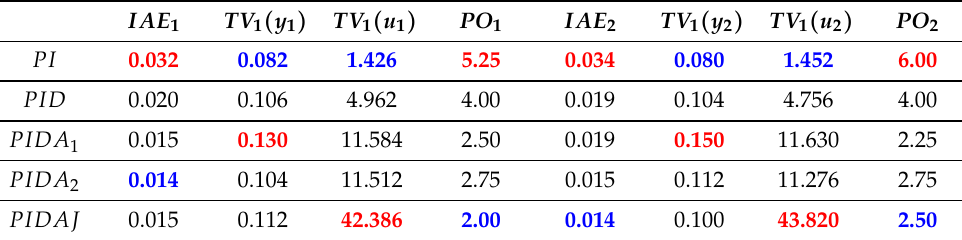
Table 2. Performance measures IAE , TV 1 ( y ) and TV 1 ( u ) corresponding to the load disturbance steps from Figures 7 and 8 calculated for t 1 ∈ [ 15,25 ) , y ( t 1 ) = y 1 , u ( t 1 ) = u 1 , w ( t 1 ) = w 1 = 0.4, t 2 ∈ [ 25,35 ) , y ( t 2 ) = y 2 , u ( t 2 ) = u 2 , w ( t 2 ) = w 2 = 0.4 with maximal (red) and minimal values (blue), PO —percentage